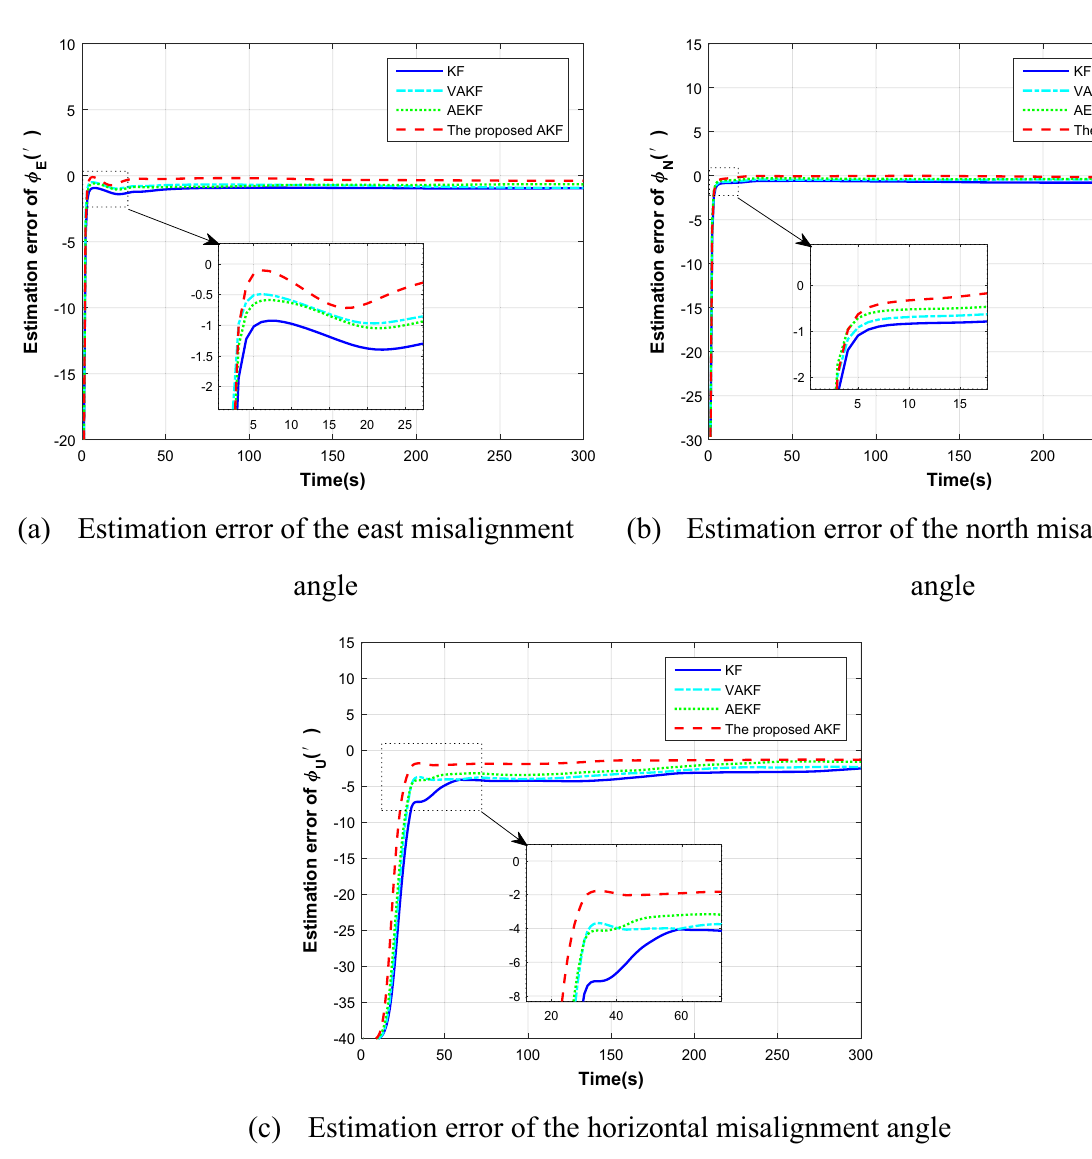
Figure 4. Misalignment angle estimation